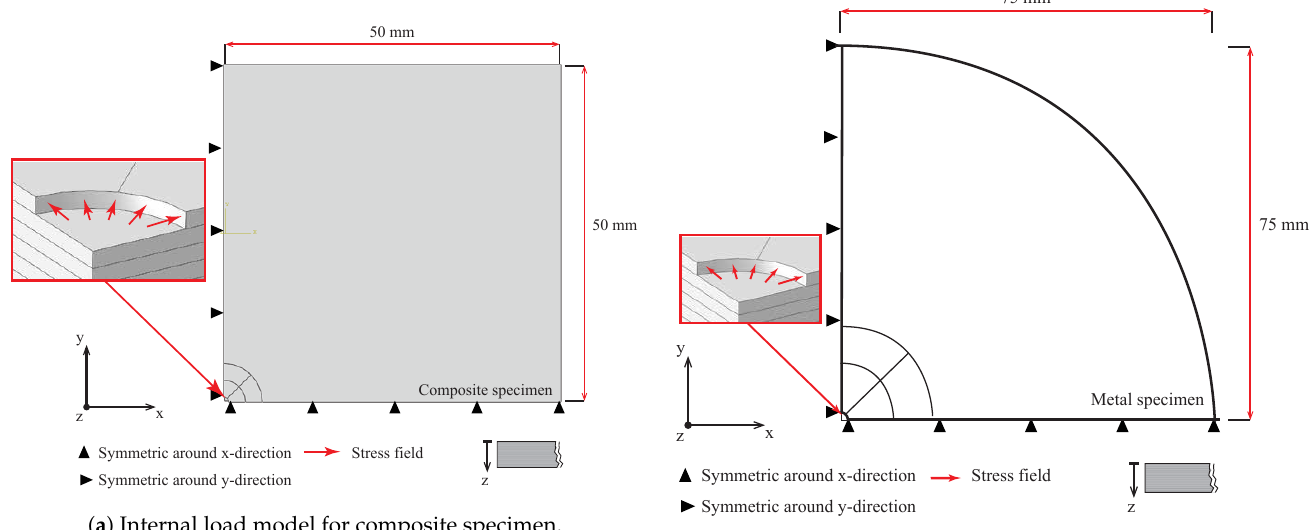
Figure 3. Internal load